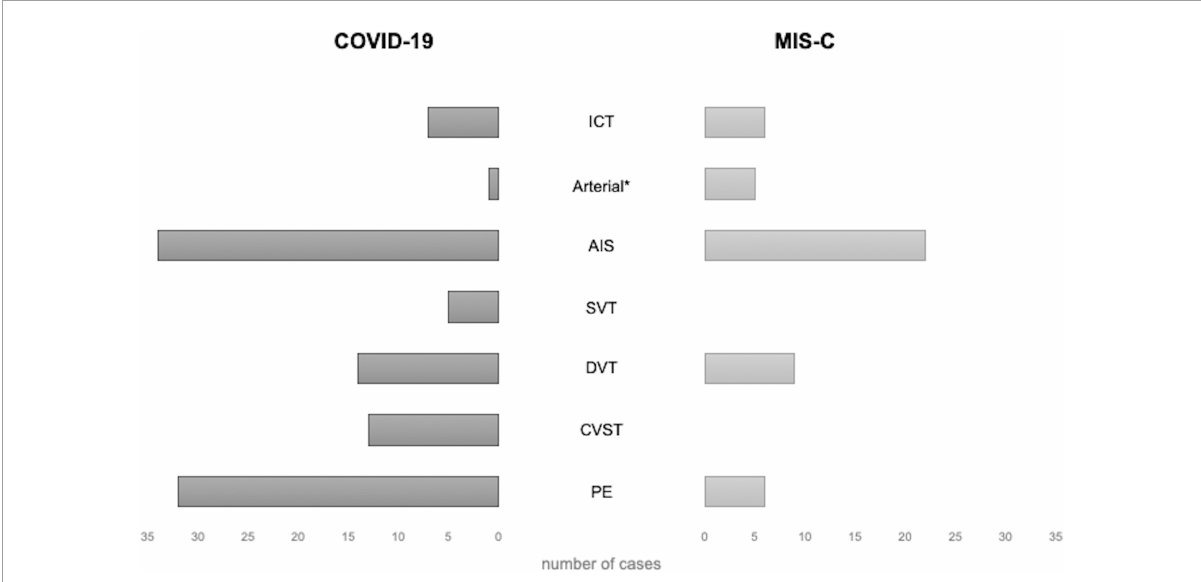
FIGURE4 Distribution of thrombotic events by localization in patients with COVID-19 and MIS-C. * excluding AIS. AIS, arterial ischemic stroke; COVID-19, coronavirus disease 2019; CVST, central venous sinus thrombosis; DVT, deep venous thrombosis; ICT, intracardiac thrombosis; MIS-C, multisystem inflammatory syndrome in children; PE, pulmonary embolism; SVT, splanchnic venous thrombosis.